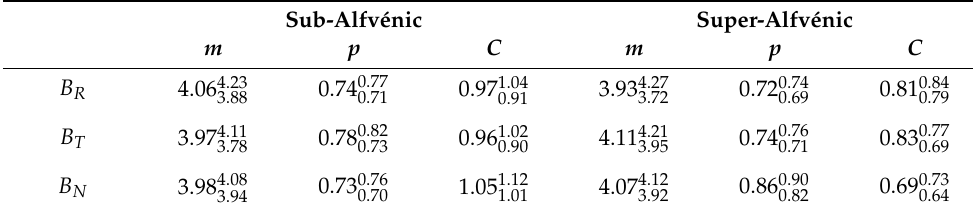
Table 1. The best-fit values of the parameters m , p , and C based on fitting the inertial range scaling exponents ζ ( q ) iner for each magnetic field component. The 95% significance range is shown as subscript and superscript. Sub-Alfvénic